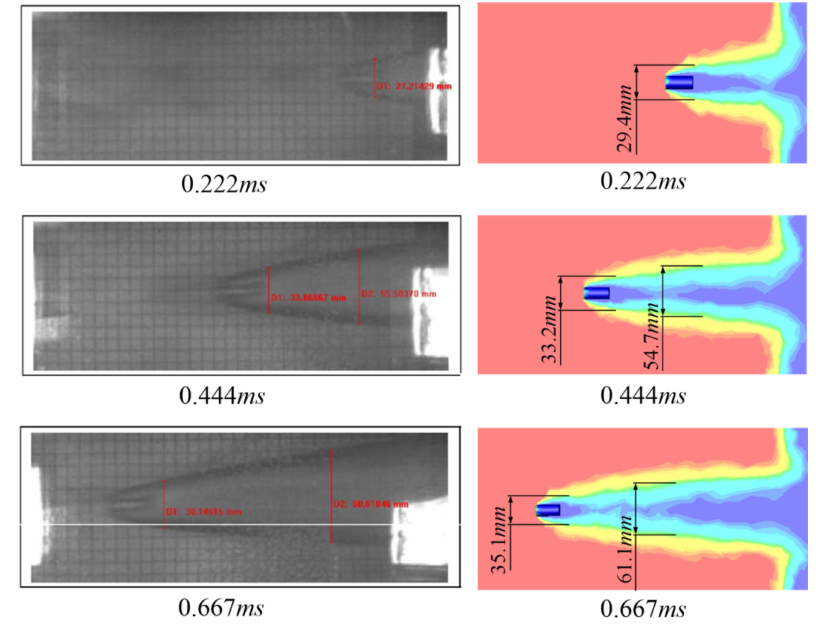
Figure 4. Experimental graph and numerical results of cavity shape of a circular cylinder.